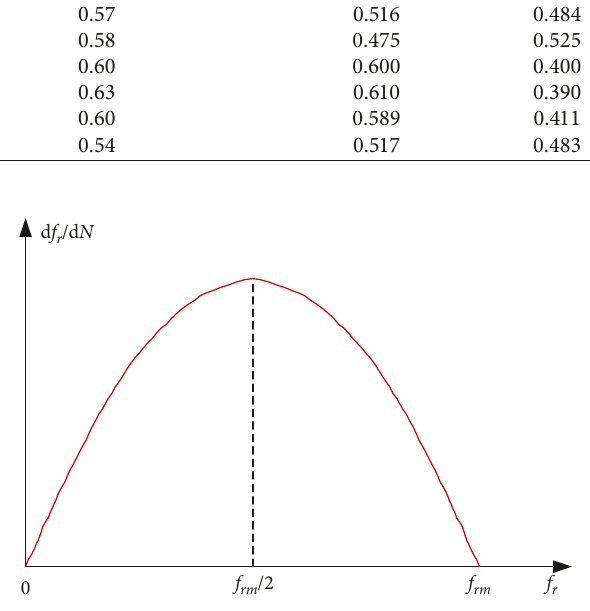
Figure 13: Residual deflection rate assumption